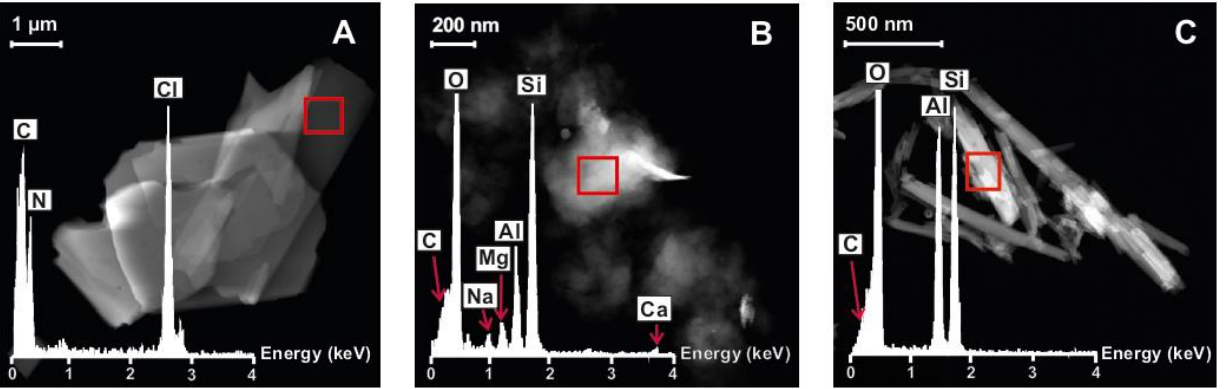
Figure 6. UHR-TEM microphotographs and EDX spectra of pristine components: CHX ( A ), BEN ( B ) and HAL ( C ).